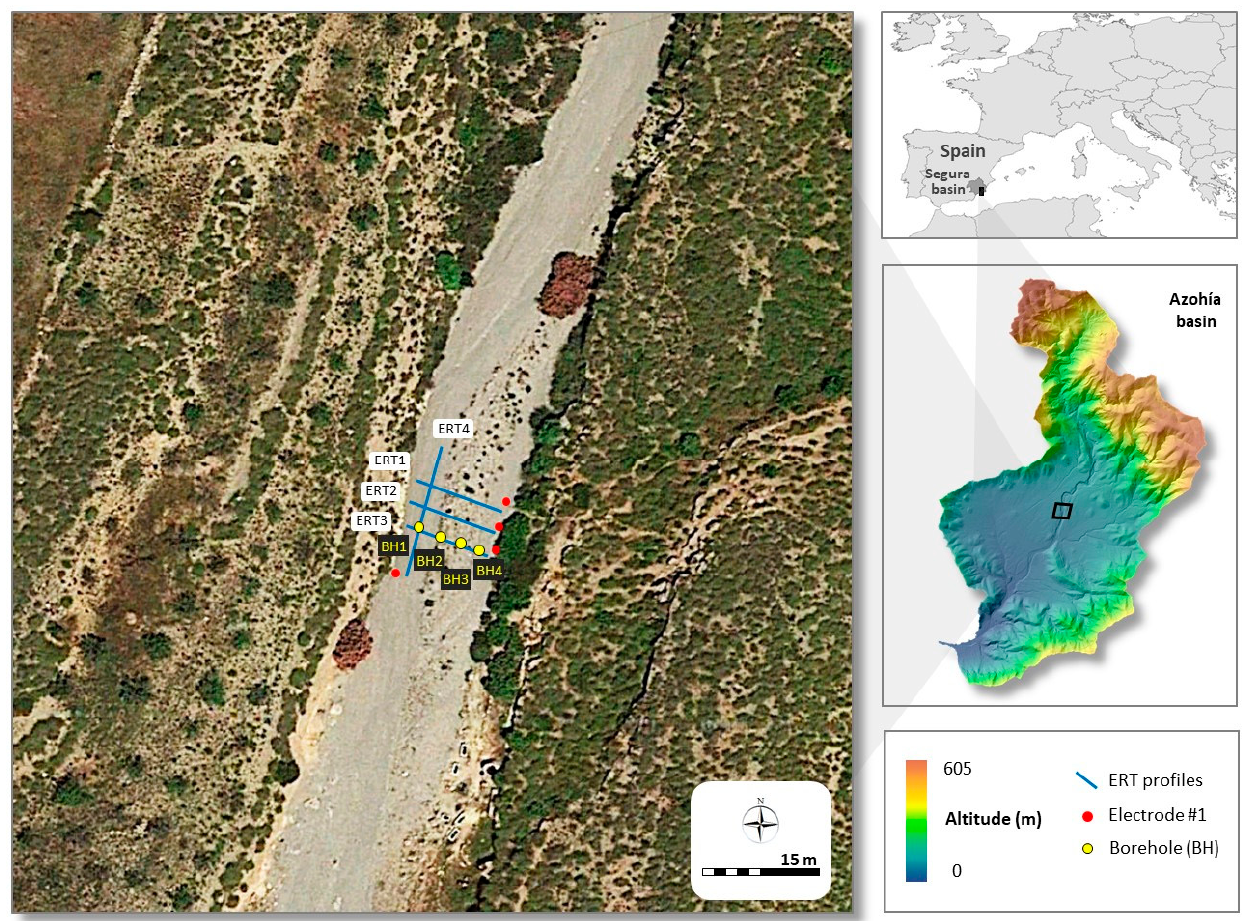
Figure 1. Study area. ERT profiles distribution, red marker determines the beginning of the electrical profile.